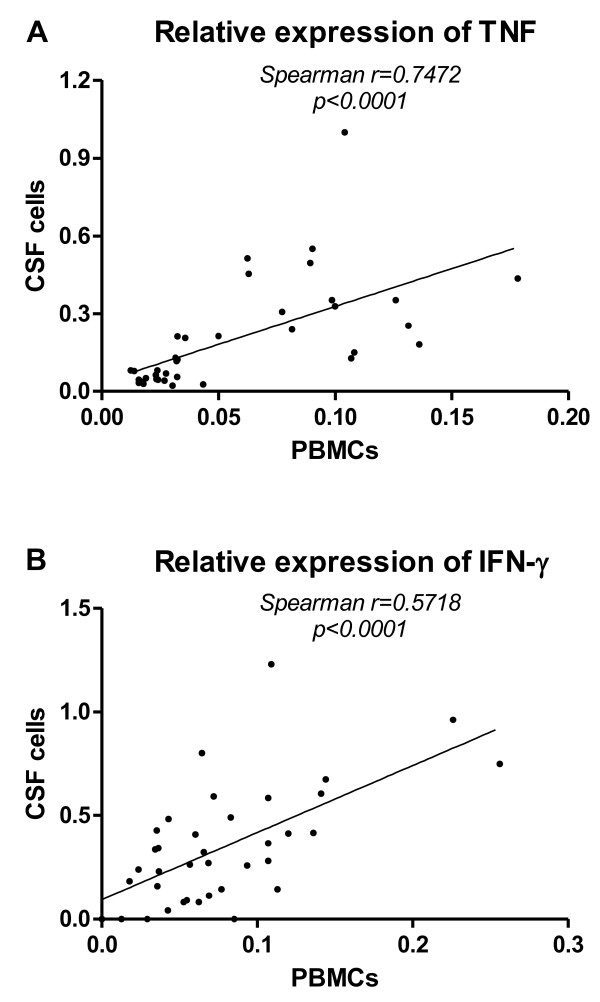
Correlation study of pro-inflammatory cytokines in systemic and intrathecal compartments.